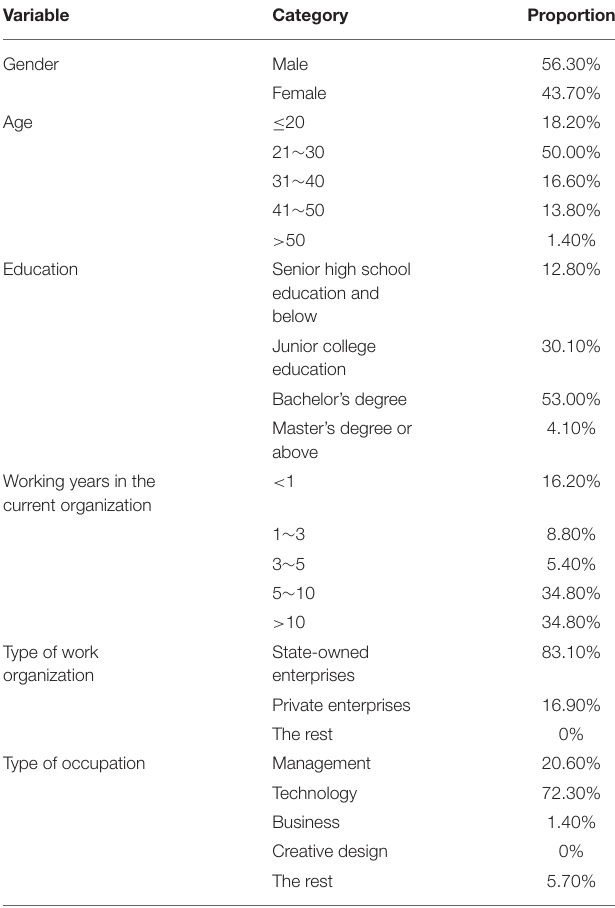
TABLE 2 | Sample distribution characteristics of